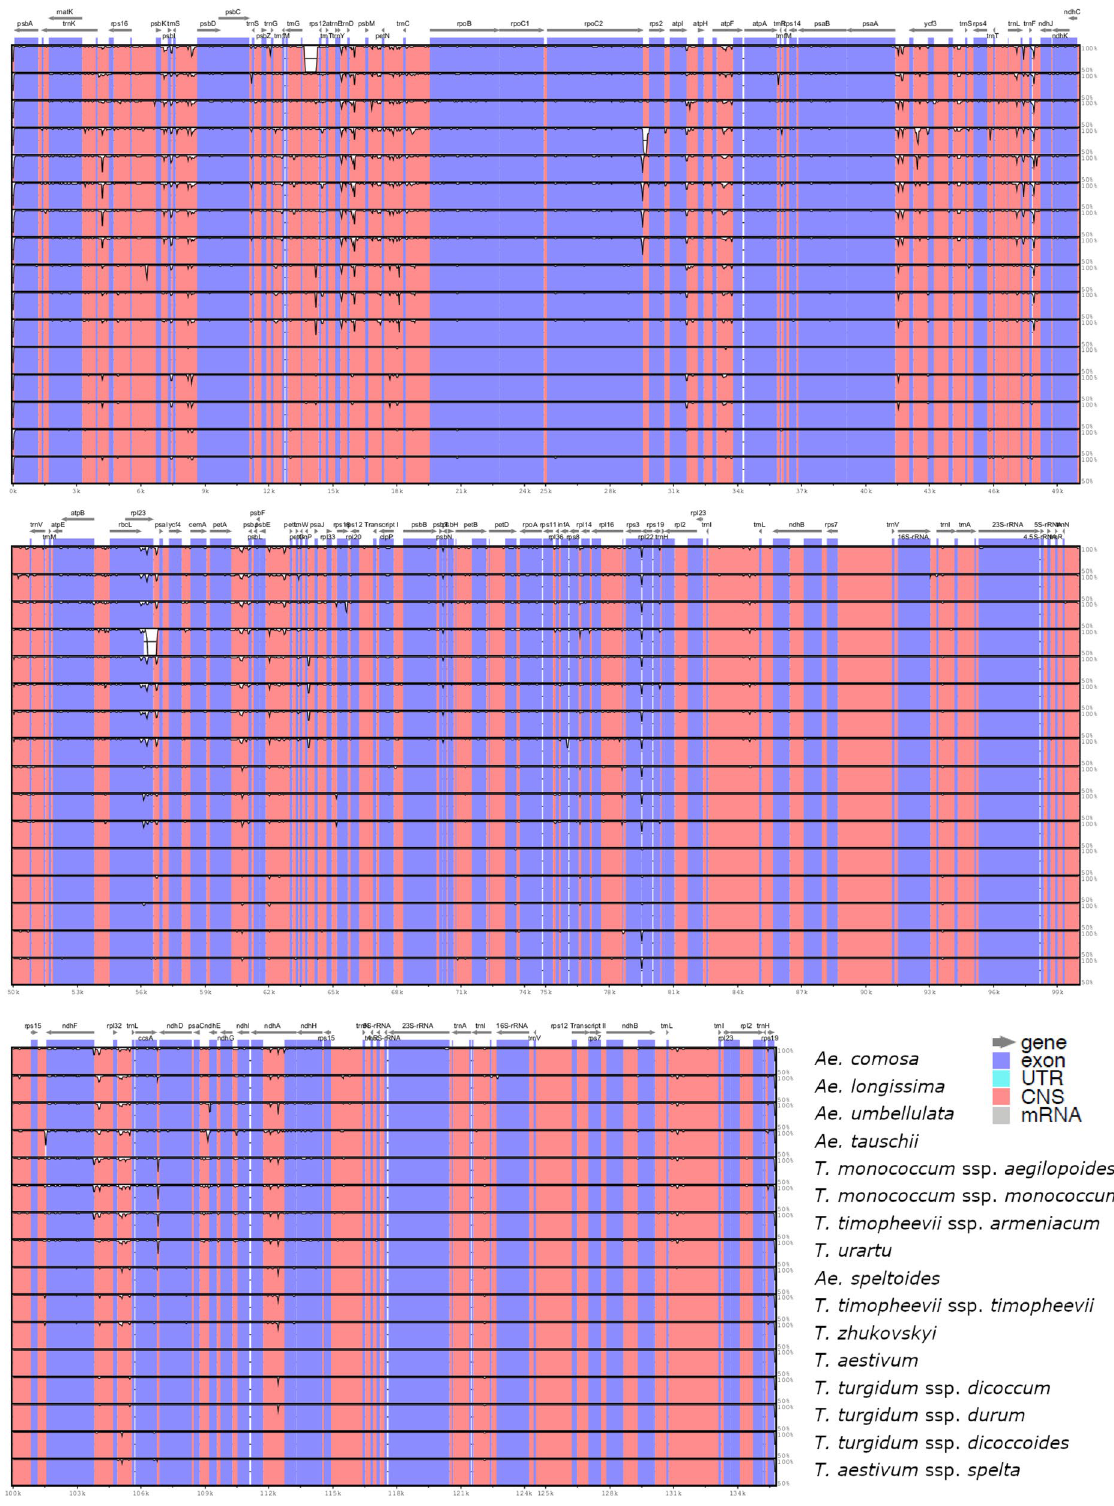
Figure 1. Percent identity plot of 16 complete Triticum and Aegilops chloroplast genome assemblies, using T. aestivum as internal reference. The vertical order of samples (or rows) followed the tree topology shown in Fig. 3. Vertical scale indicates the percentage of identity ranging from 50 to 100%. Coding regions are in blue and non-coding regions are in orange. Note that the plot was generated using mVISTA 42 (http:// genome. lbl. gov/ vista/ mvista/ about. shtml) and merging the output figure with the GNU Image Manipulation Program version 2.8.20 (http:// www. gimp.